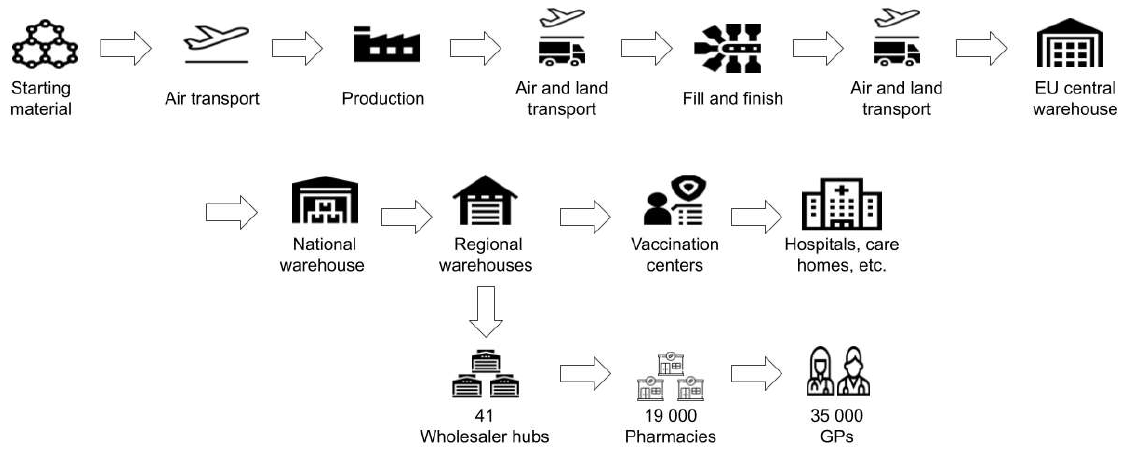
Figure 1. Supply chain and last mile delivery process for mRNA vaccines in Germany.